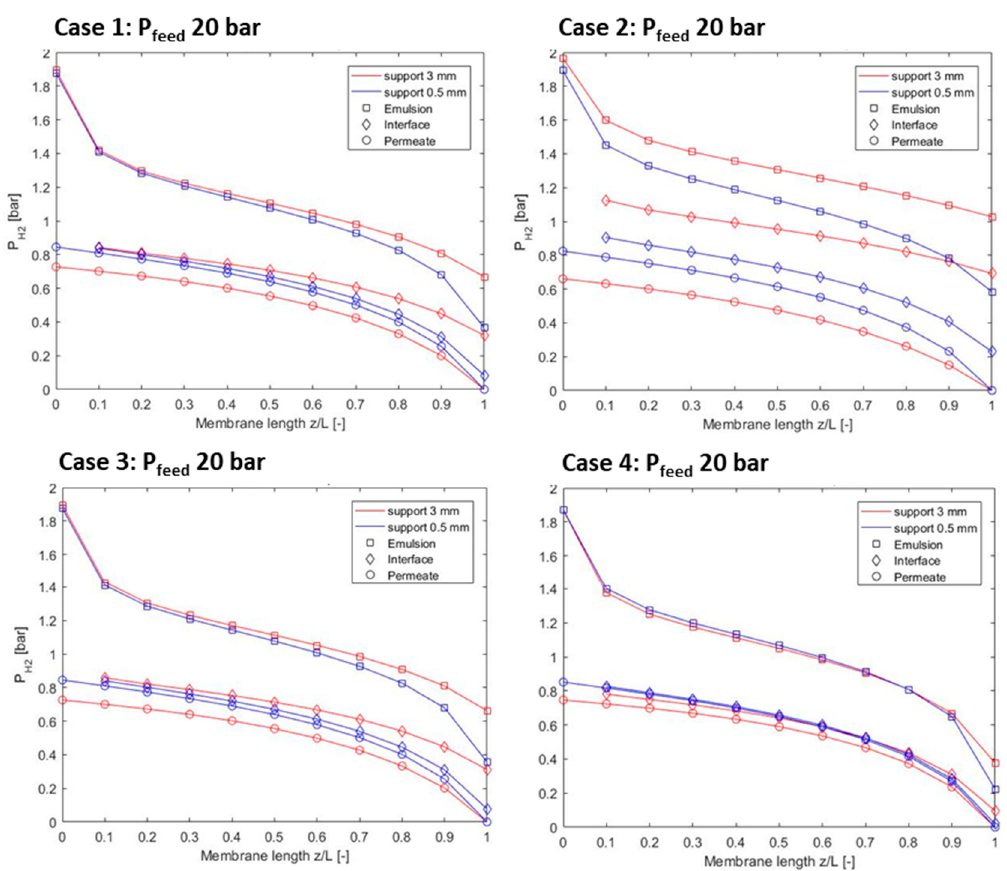
Figure 3. Pressure gradients comparison for the considered cases.